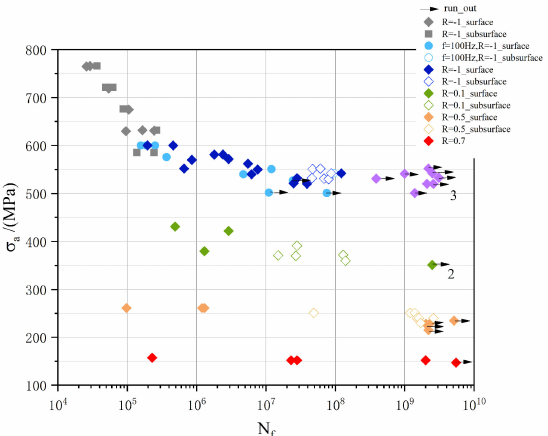
Figure 1. The S–N curves of Cr-based steel at room temperature (RT).